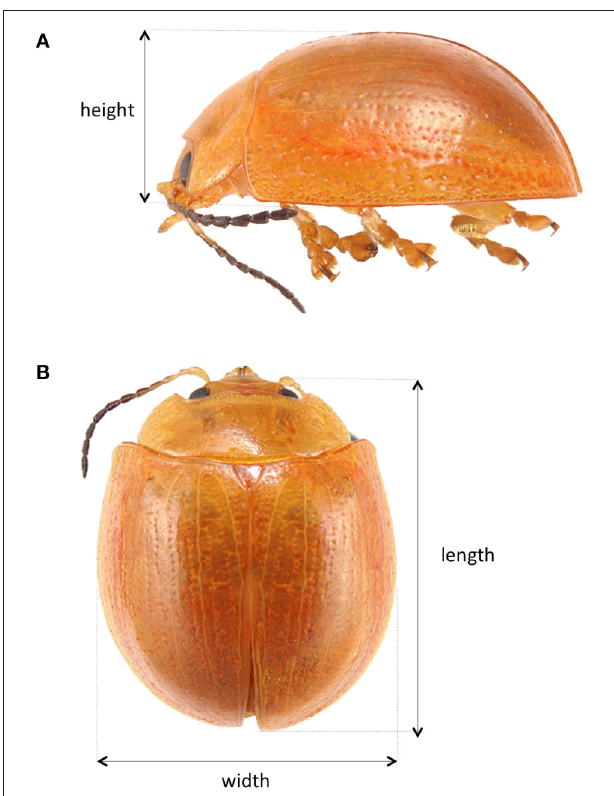
FIGURE 2 | Measurements of the dimensions of a beetle. (A) Lateral view of beetle depicting height measurement; (B) Dorsal view of beetle depicting length and width measurements. Convexity is defined as the ratio of the beetle height to length. Images by Kindi Smith, © Australian